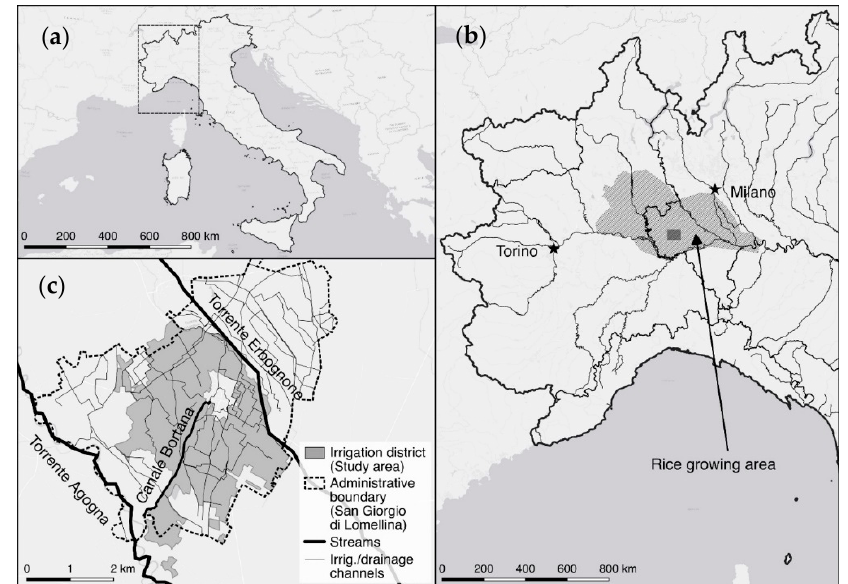
Figure 1. ( a ) General overview of Italy; ( b ) Focus on the north-western part of Italy: the Lombardy-Piedmont rice area is dark-shaded, lakes and seas are light-shaded, major rivers are depicted by thin lines and the black box is centered on the study area; ( c ) Study area (dark-shaded), Agogna and Erbognone streams delimiting the district (bold lines), irrigation and drainage channels network (thin lines) including a deep channel draining groundwater (Bortana).